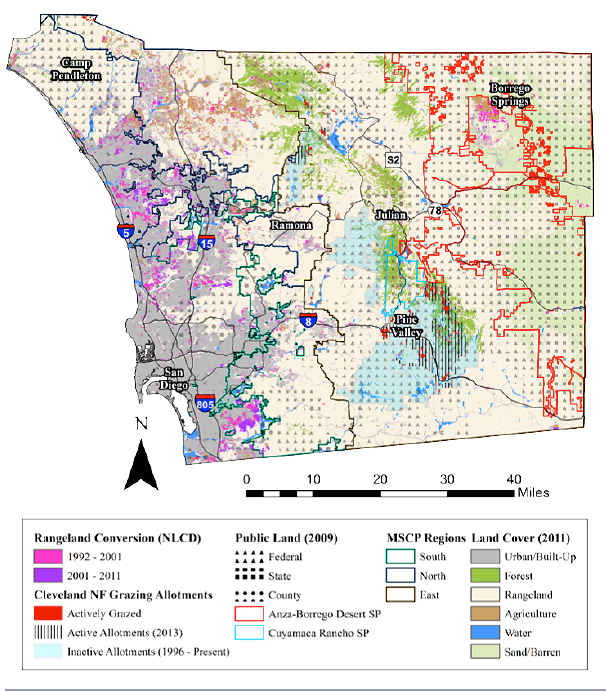
Fig. 1. Rangeland conversion and public rangelands in San Diego County, California, USA, 1992–2011. Land-cover data were obtained from the National Land Cover Database (NLCD). Data for the extent of public land holdings